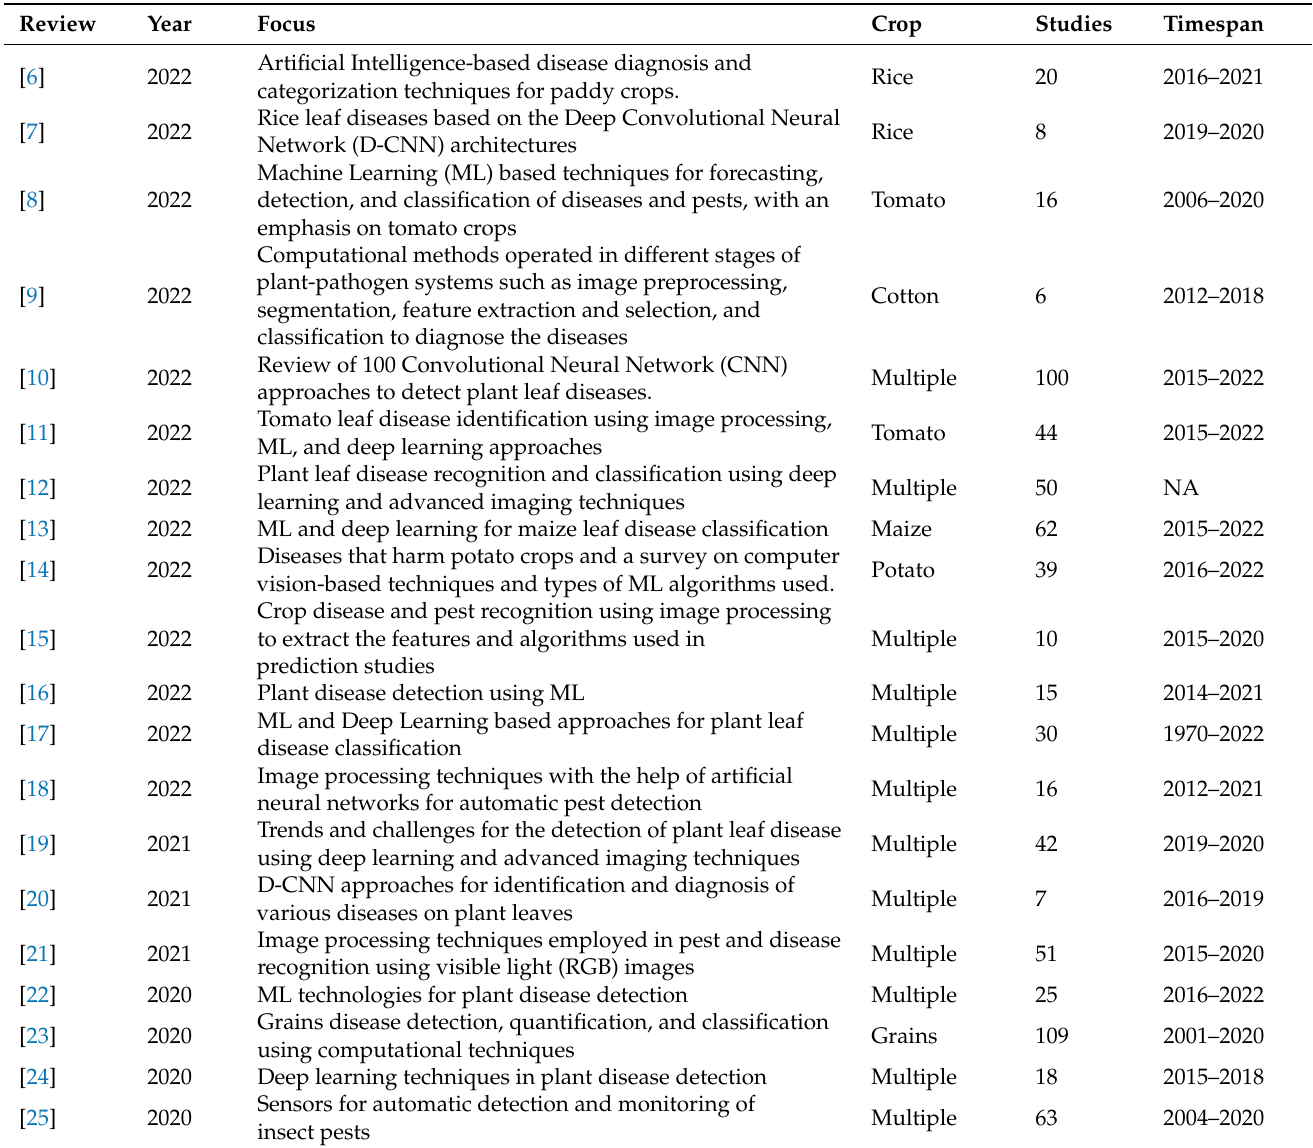
Table 1. Studies reviewing the detection, identification, and classification of diseases and pests in agricultural